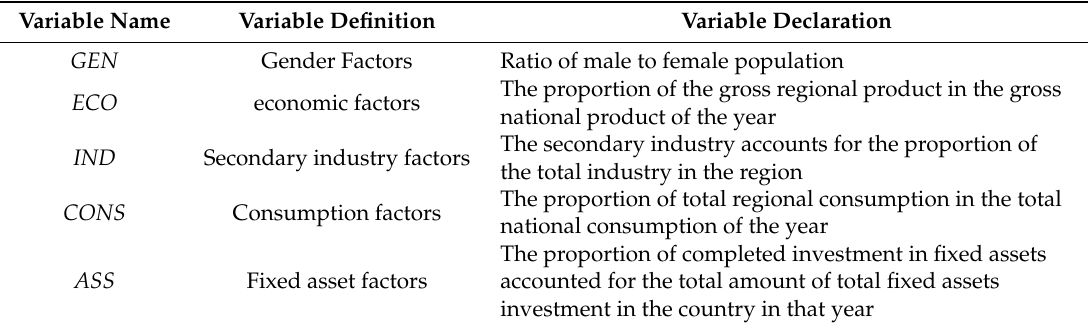
Table 4. Meanings and explanations of indicators of control variables.